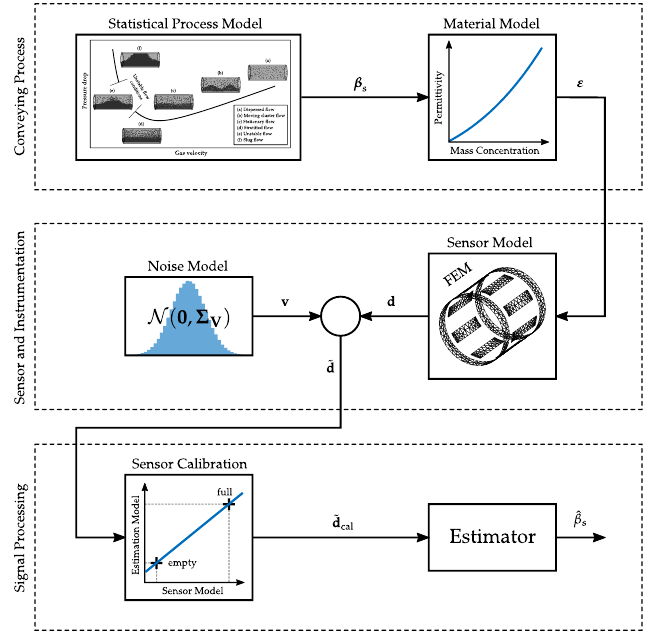
Figure 4. Holistic model of the measurement process of a capacitive mass concentration measurement system for pneumatic conveying